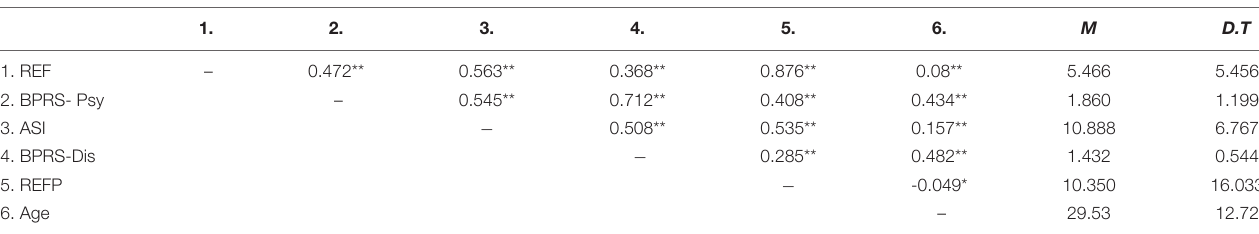
TABLE 2 | Means, standard deviations, and Spearman correlations between study